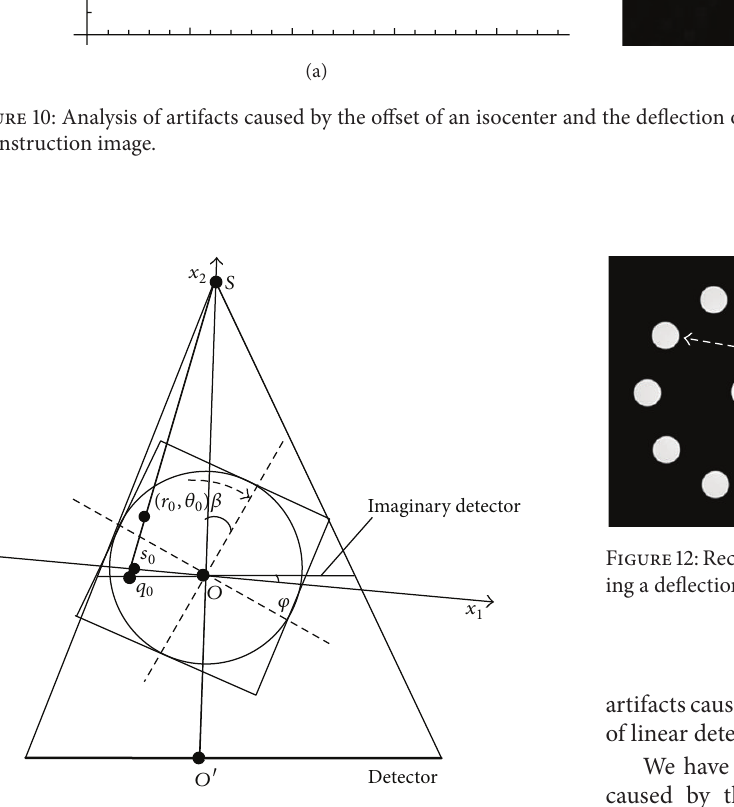
Figure 11: A geometric relationship of FBP formula derivation in- cluding a deflection angle of linear detectors.